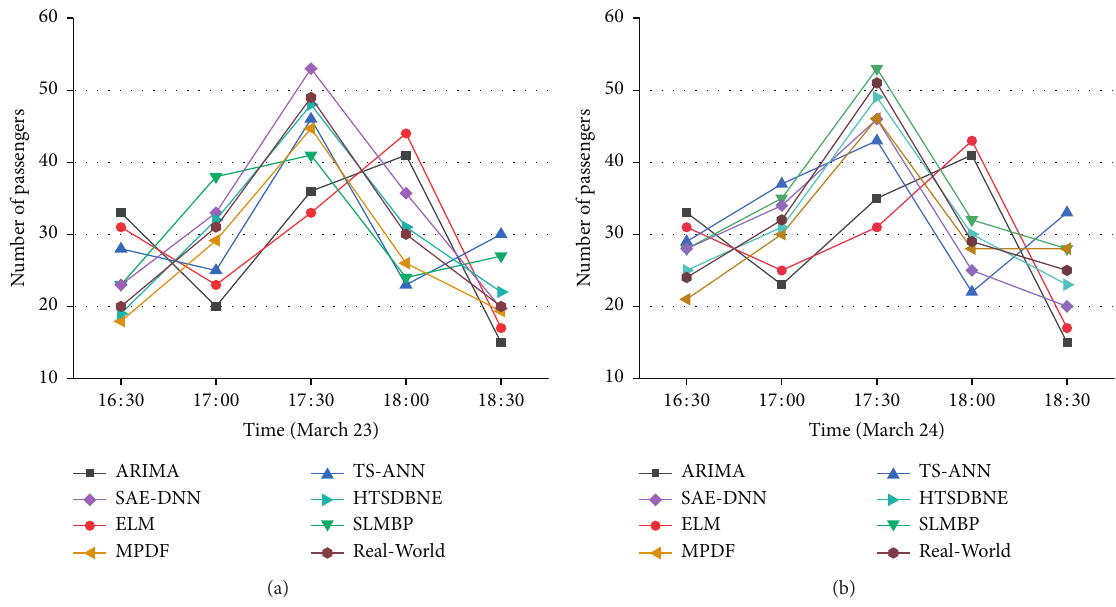
Figure 18: Comparison between HTSDBNE and other models in the evening peak hours of nonworking days (station 7 of line 28).